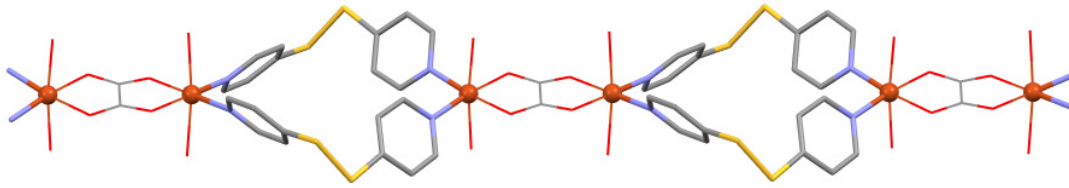
O] (MEFMEQ), showing 2 n